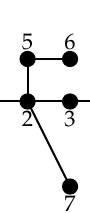
Figure 1. Main aspects of the solution of an optimization problem in GAMS software.